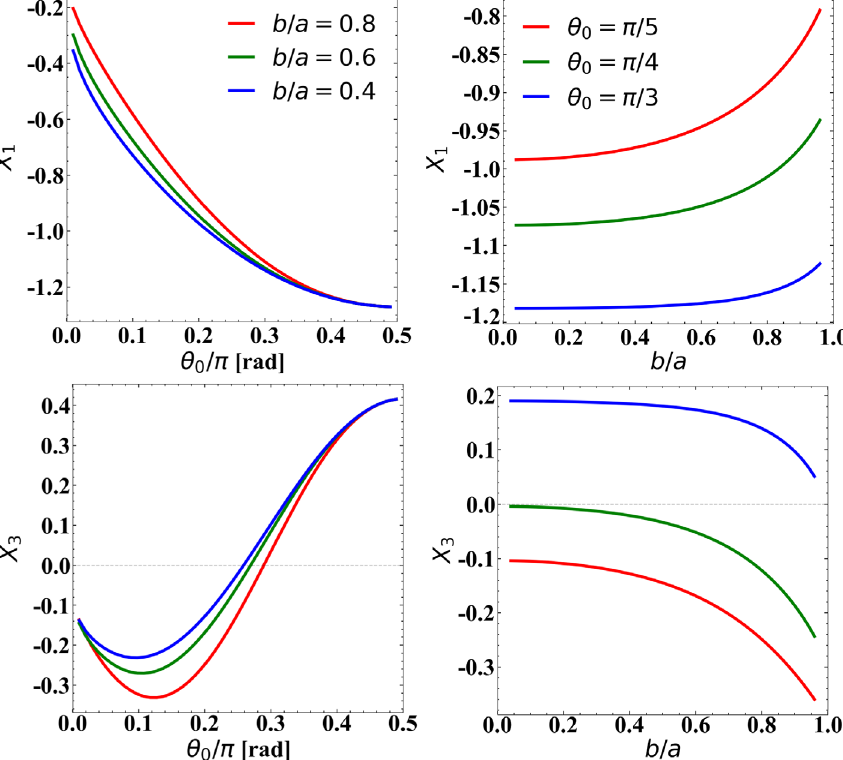
.FIG. 4. Odd mode: Variation of the two lowest order coefficients with half coverage angle θ 0 for different values of b (left) and with b=a (right) for different values of θ 0 . Top row: X 1 , Bottom row: X 3 b=a for π = 3 ≤ θ 0 < π = 2 . The bottom plot shows that X 3 is